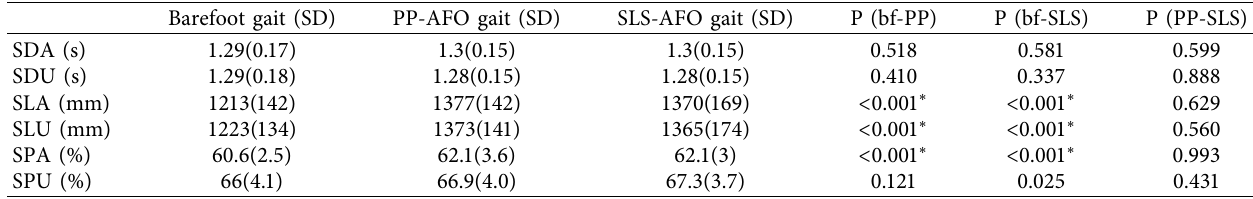
Figure 7: (a) Te workfow used in the computer-aided design (CAD) of the AFOs. PP-AFO (b) and SLS-AFO (c) of one subject participating in the study. Table 1: Spatial-temporal gait parameters and results of the statistical analysis.